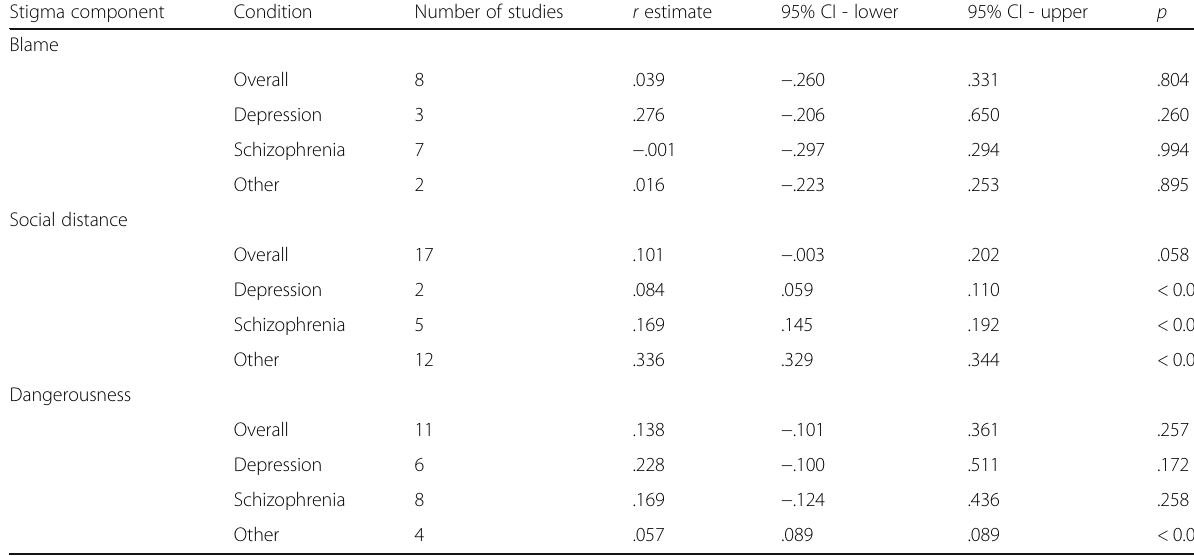
Table 3 Summary of meta-analytic findings from correlational studies Stigma